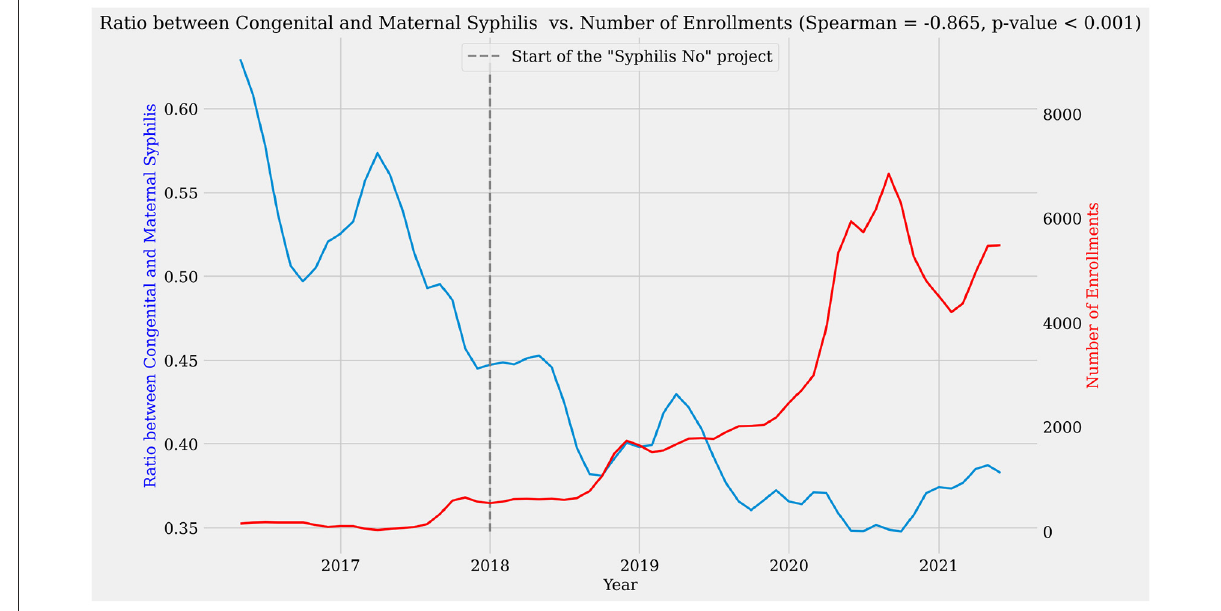
FIGURE10 Correlation between the number of enrollments in the learning pathway and the ratio of CS and SIP case notifications.